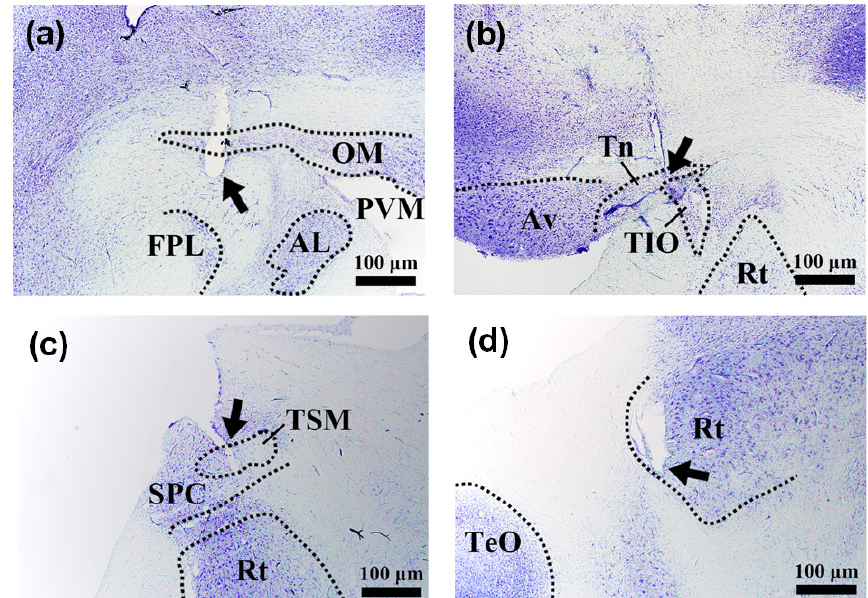
Figure 7. Histology of pigeon brain to confirm electrode insertion coordinates. The pigeon ( a ) turned to the right on tractus occipito-mesencephalicus (OM) stimulation, ( b ) flew to the left on nucleus taeniae (TN) stimulation, ( c ) flapped both wings or took-off on tractus septo-mesencephalicus (TSM) stimulation, and ( d ) turned to the left on nucleus rotundus (RT) stimulation.